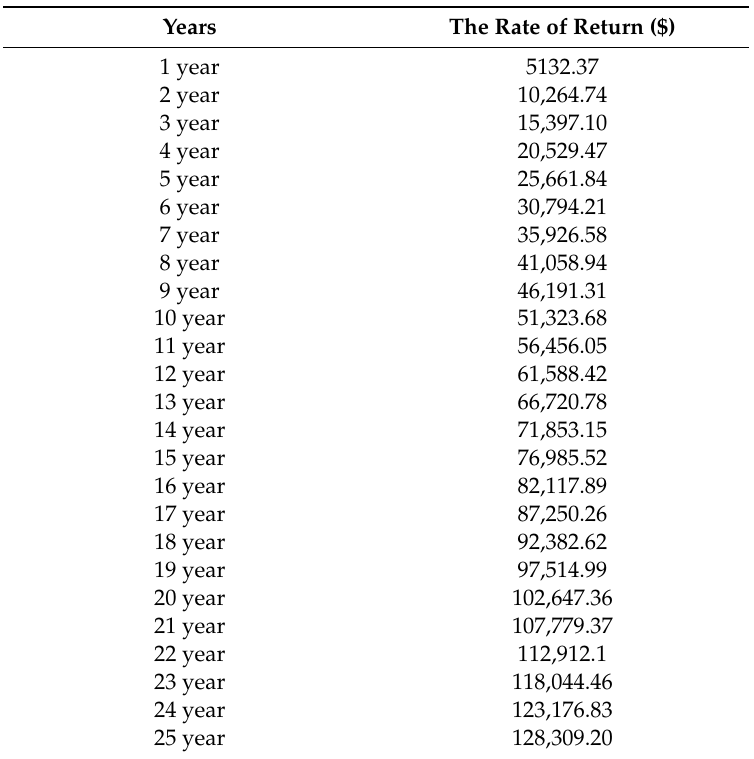
Table 7. The rate of return on investment due to energy generation throughout the 25-year